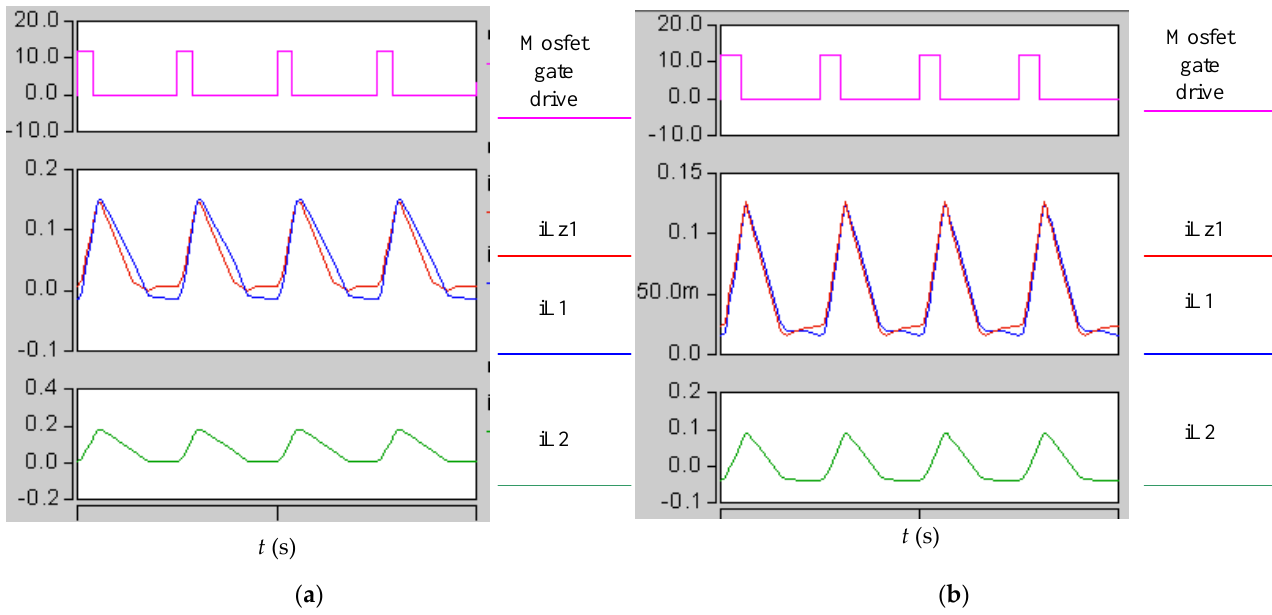
Figure 10. Simulation waveforms of the DCM operation. ( a ) Light discontinuous operation waveform; ( b ) deep discontinuous operation waveform.